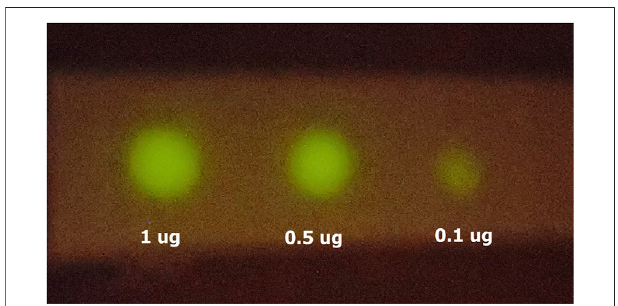
FIGURE 9 | Smartphone imaging of spotted antibodies against SARS- CoV-2 nucleoprotein, revealed with ZZ-AmyLuc and its assay solution. The image was obtained with a Galaxy S10 Plus